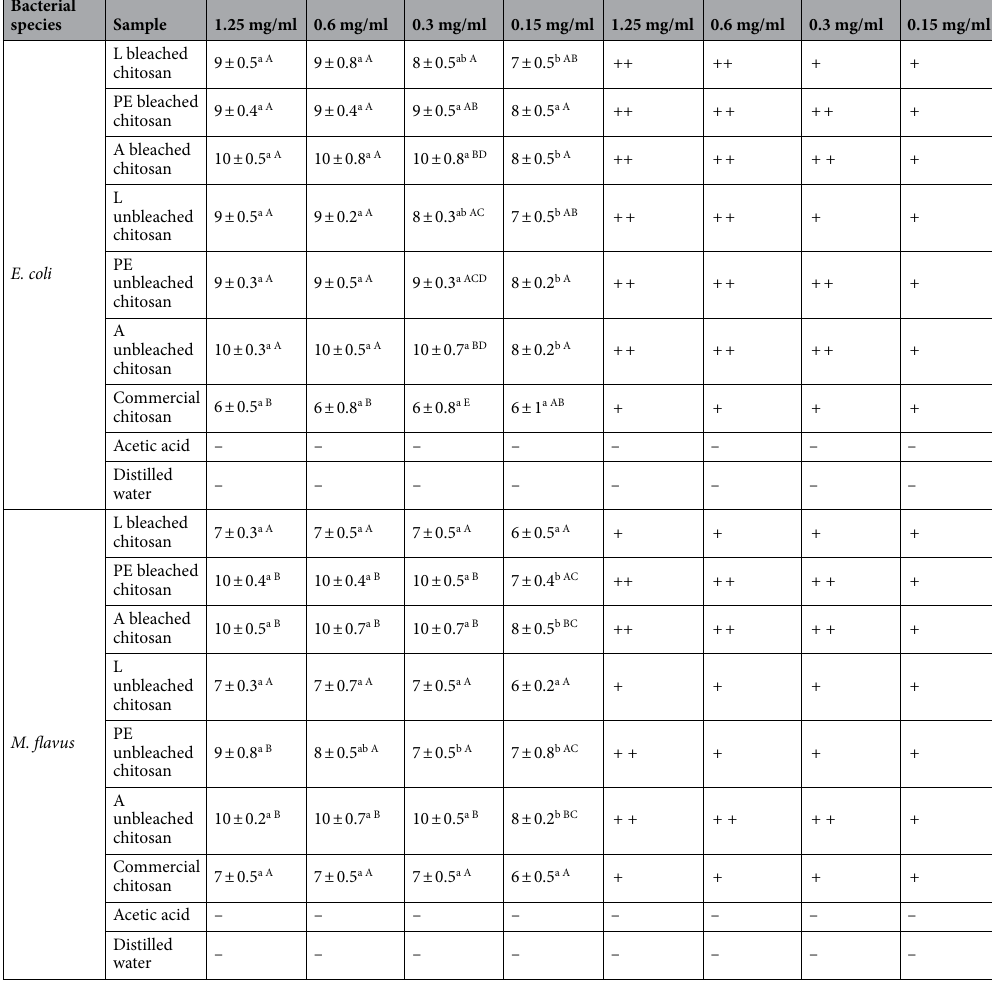
Table 1. Diameters (mm) of inhibition zones formed by bleached and unbleached chitosan samples produced from H. illucens larvae (L), pupal exuviae (PE) and dead adults (A), commercial chitosan and acetic acid at five different concentrations (1.25, 0.6, 0.3 and 0.15 mg/ml) on E. coli and M. flavus . Distilled water was tested as negative control. Results are expressed as mean ± standard deviation of diameters measured with agar diffusion test of three independent biological replicates. Different letters indicate significant differences ( p < 0.05) among treatments for the same concentration (capital letters) and among different concentrations in the same treatment (lowercase letters). The intensity of the antibacterial activity of each sample was evaluated according to the scale proposed by El-masry et al. 63 and expressed with different symbols depending on the diameter of the respective inhibition zone: + + + (inhibition zone > 12 mm, high activity), + + (inhibition zone 9–12 mm, moderate activity), + (inhibition zone 6–9 mm, slight